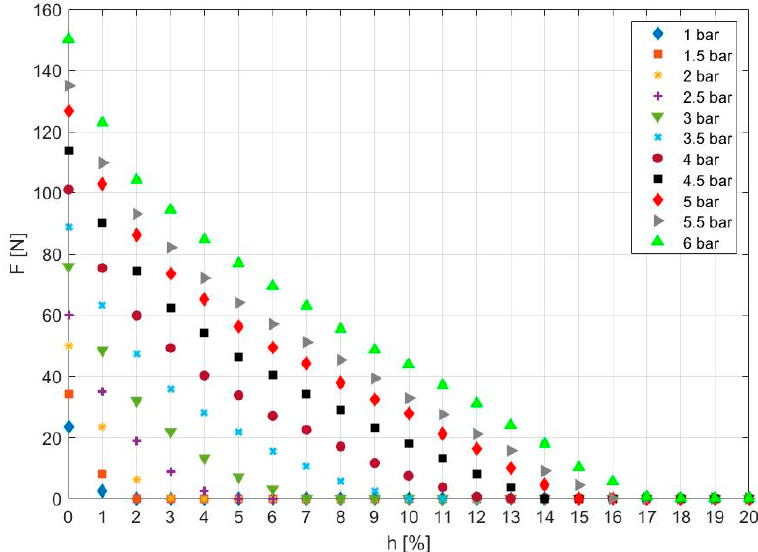
Figure 11. Force characteristics of FESTO’s DMSP − 5 muscle measured using the experimental setup shown in Figure 3.